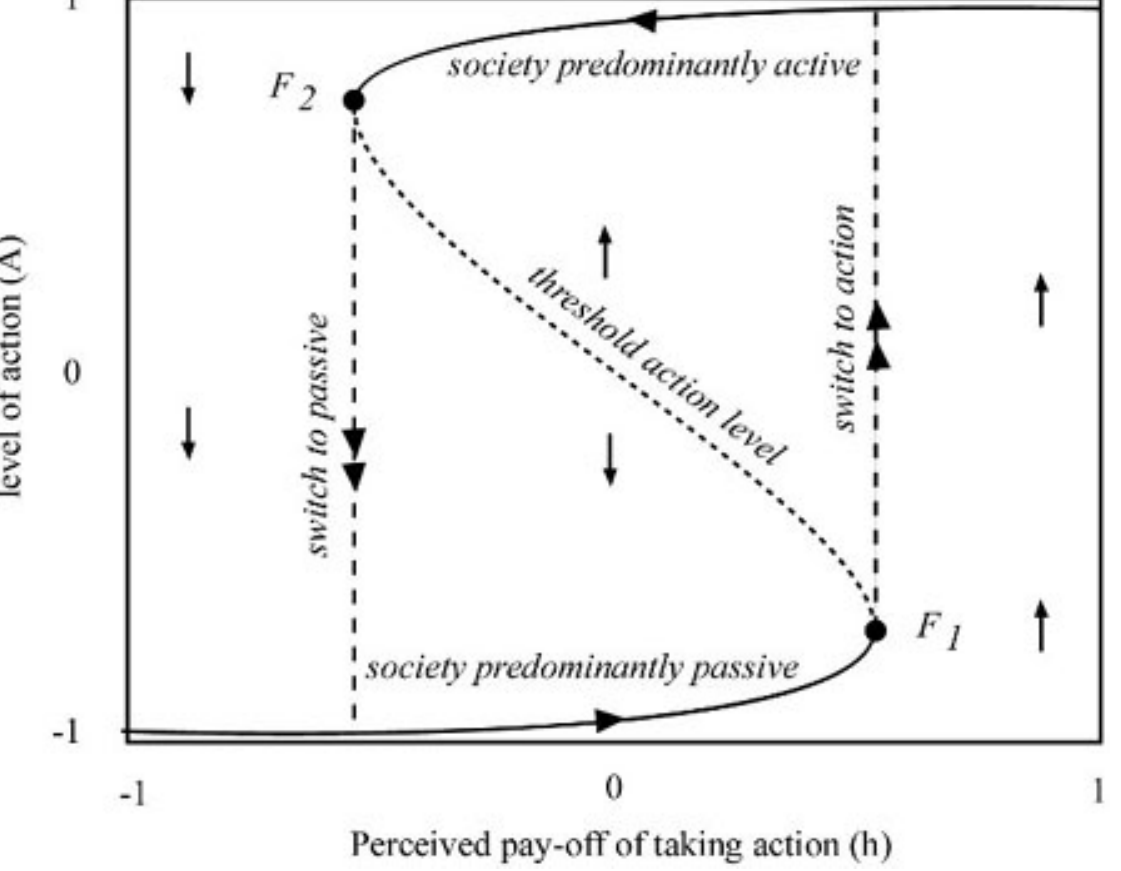
Fig. 4. In societies with little difference among individuals and high peer pressure, the response of public attitude to an increase in perceived problem size is predicted to be discontinuous. When the problem is perceived to be small (and the perceived pay-off of taking action is low), the attitude of most individuals is passive with respect to the problem. Society abruptly shifts to a predominantly active attitude (creating political pressure to regulate the problem) when the perceived severity of the problem has grown sufficiently to reach a critical point (F1). If, subsequently, the severity of the problem is reduced, the active attitude toward regulation remains until another critical threshold point (F2) is reached where an equally abrupt transition to a passive attitude occurs. (From Scheffer et al.